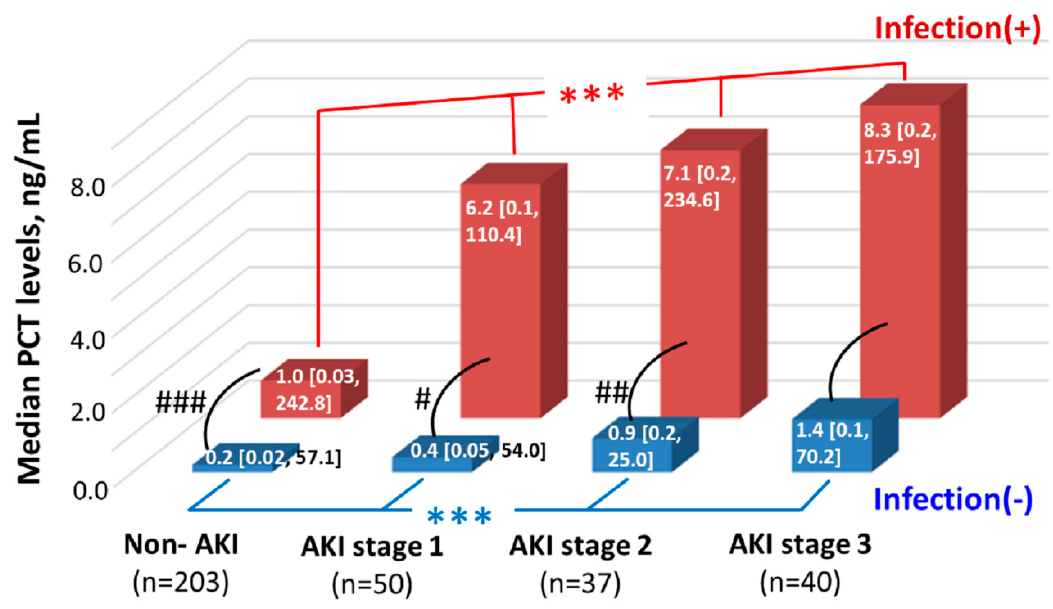
Figure 3. Median PCT levels among groups stratified by AKI stages and infection. Note: Data are expressed as median (range). *** denotes p < 0.001 in the comparisons of serum PCT levels among patients with different AKI stages using the Kruskal–Wallis test. #, ##, ### denote p < 0.05, <0.01, <0.001, respectively, in the comparison of serum PCT levels between infection (+) group and infection ( − ) group using the Mann–Whitney U test. Abbreviations: AKI = acute kidney injury; PCT = procalcitonin.